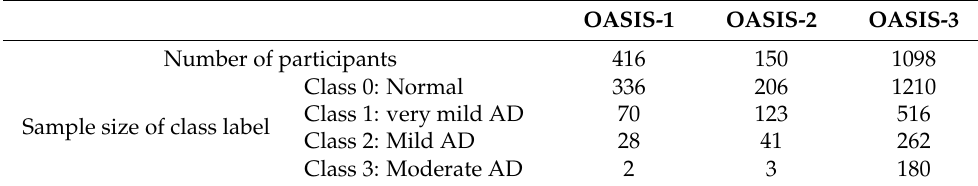
Table 1. Constituents of OASIS-1, OASIS-2, and OASIS-3.